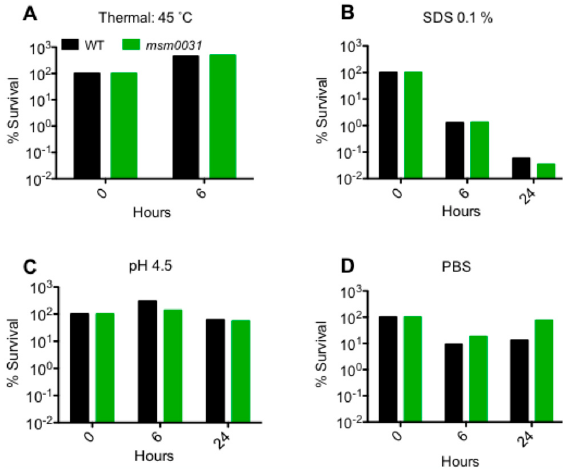
Figure 4. Sensitivity of the msm0031::Tn mutant and wild-type M. smegmatis cells to ( A ) 45 °C; ( B ) 0.1% sodium dodecyl sulfate; ( C ) pH 4.5; and, ( D ) PBS (1X).